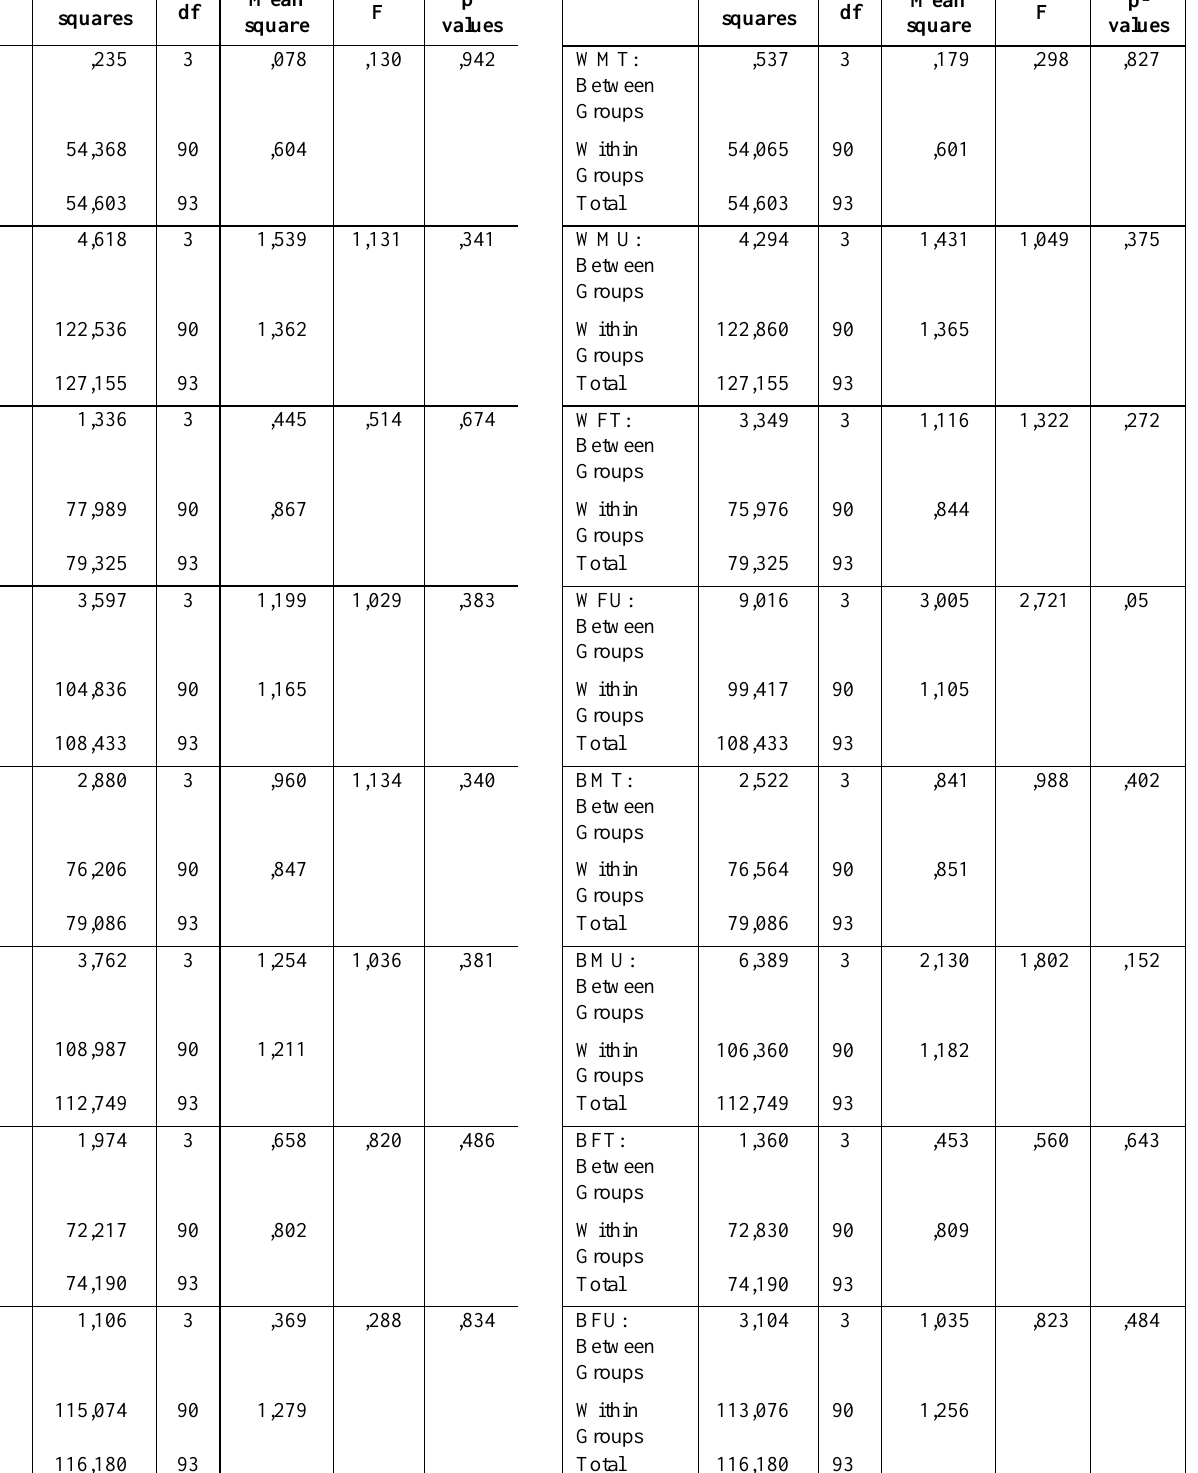
Table 8: ANOVA results: Two-way interactions between race and neatness Sum of